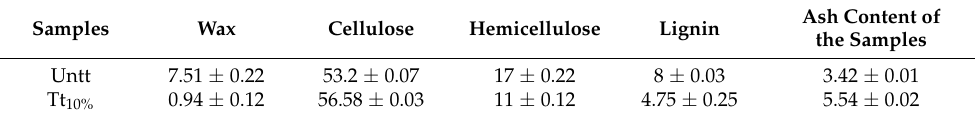
Table 2. The chemical constituents of both untreated and NaOH-treated fibers.